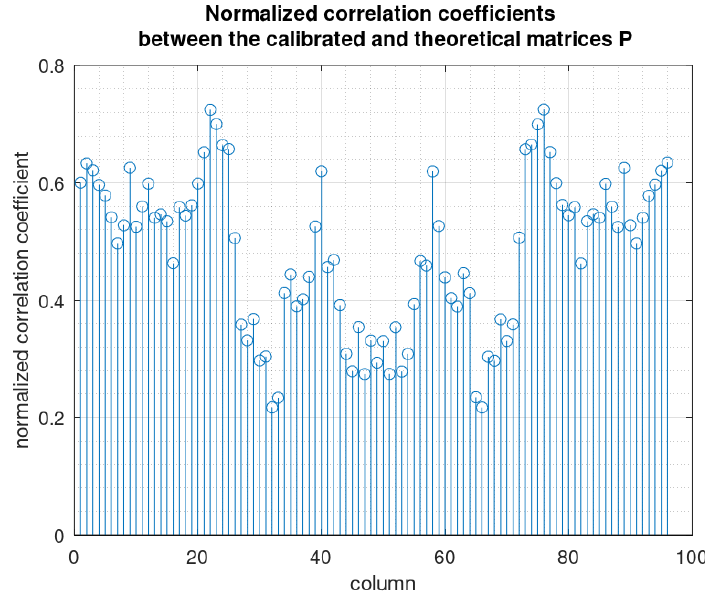
Figure 17. Normalized correlation coefficients.